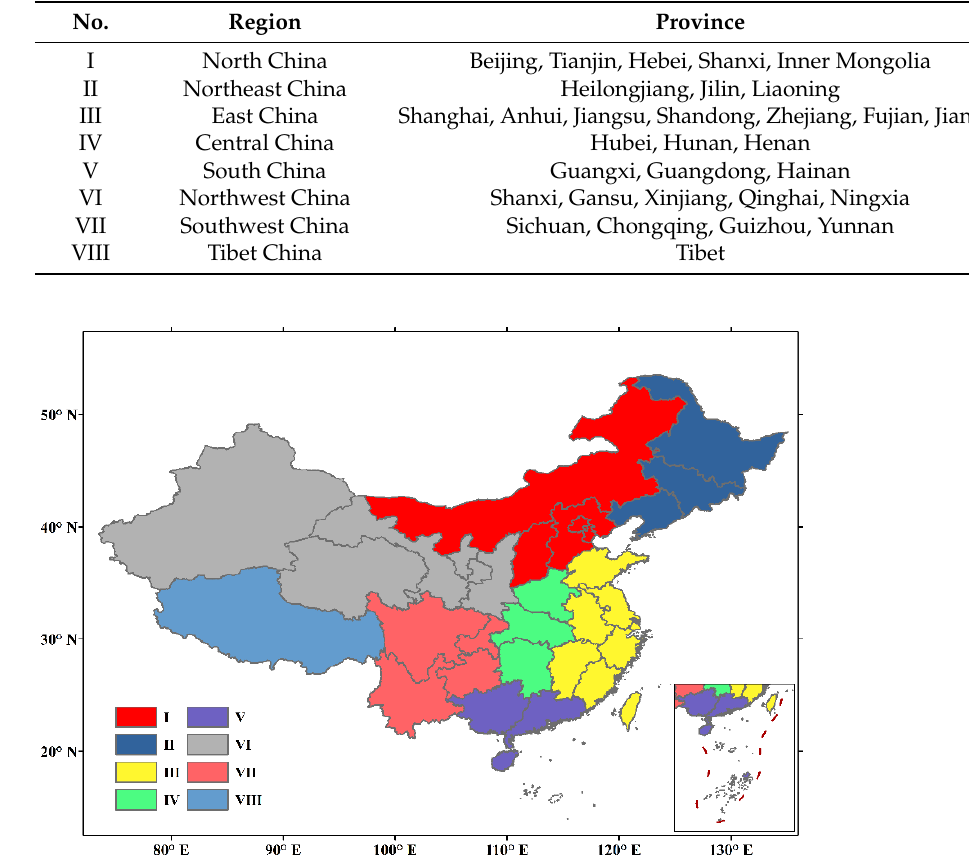
Figure 8. Climatic regional division